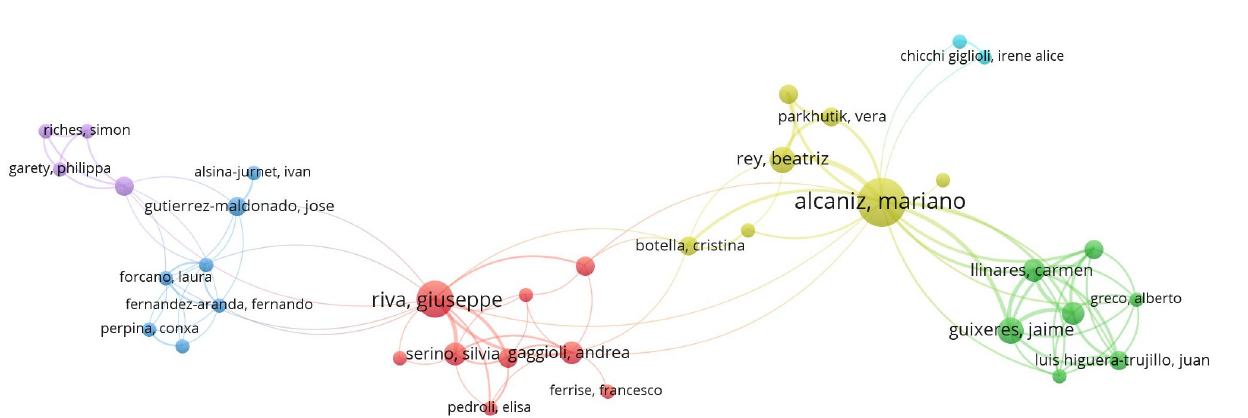
Figure 7. Map of author collaboration networks.